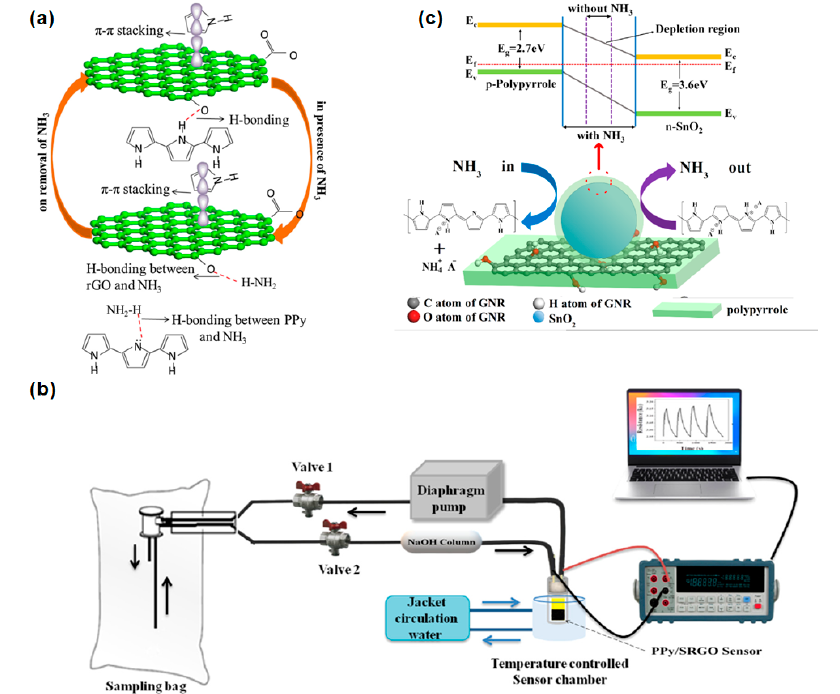
Figure 6. ( a ) Schematic diagram of the interaction between NH 3 and PPy/rGO [64]. Copyright (2017), used with permission from Elsevier. ( b ) Device of PPy/srGO nanocomposite gas sensor [7]. Copyright (2021), used with permission from Elsevier. ( c ) The energy band diagram and sensing mechanism of the PPy/SnO 2 /GNR nanocomposite sensor [65]. Copyright (2021), used with permission from Elsevier.